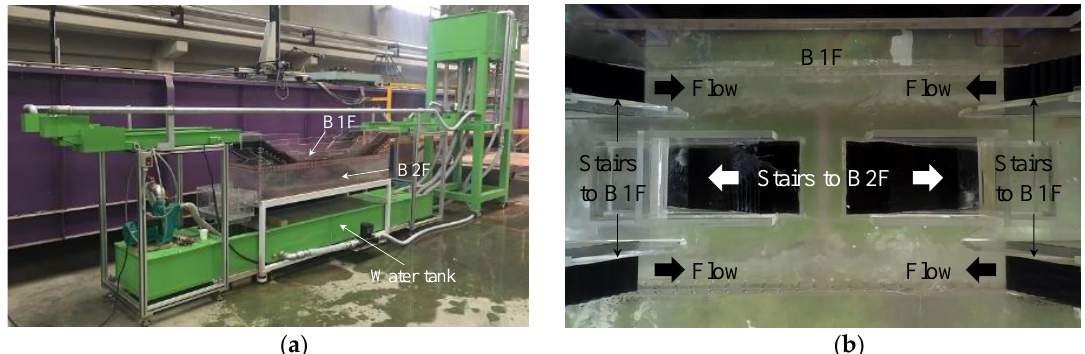
Figure 1. Subway station model for inundation experiments: ( a ) Experiment channel; ( b ) Plan view of B1F.